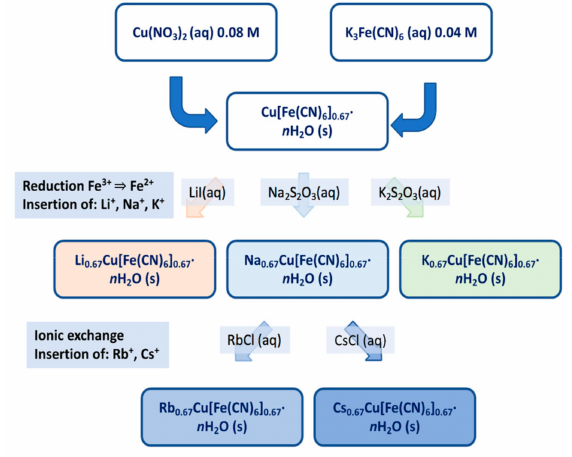
Figure 2. Graphical illustration of the synthesis